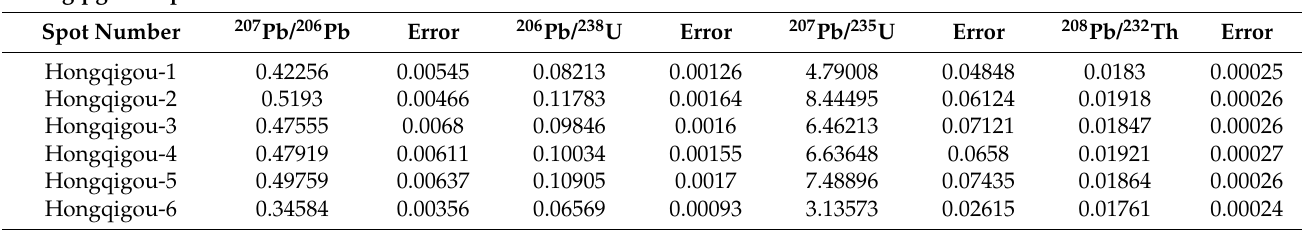
Table 1. The results of the LA–ICP–MS U–Pb dating on hydrothermal monazite in the Wulonggou gold